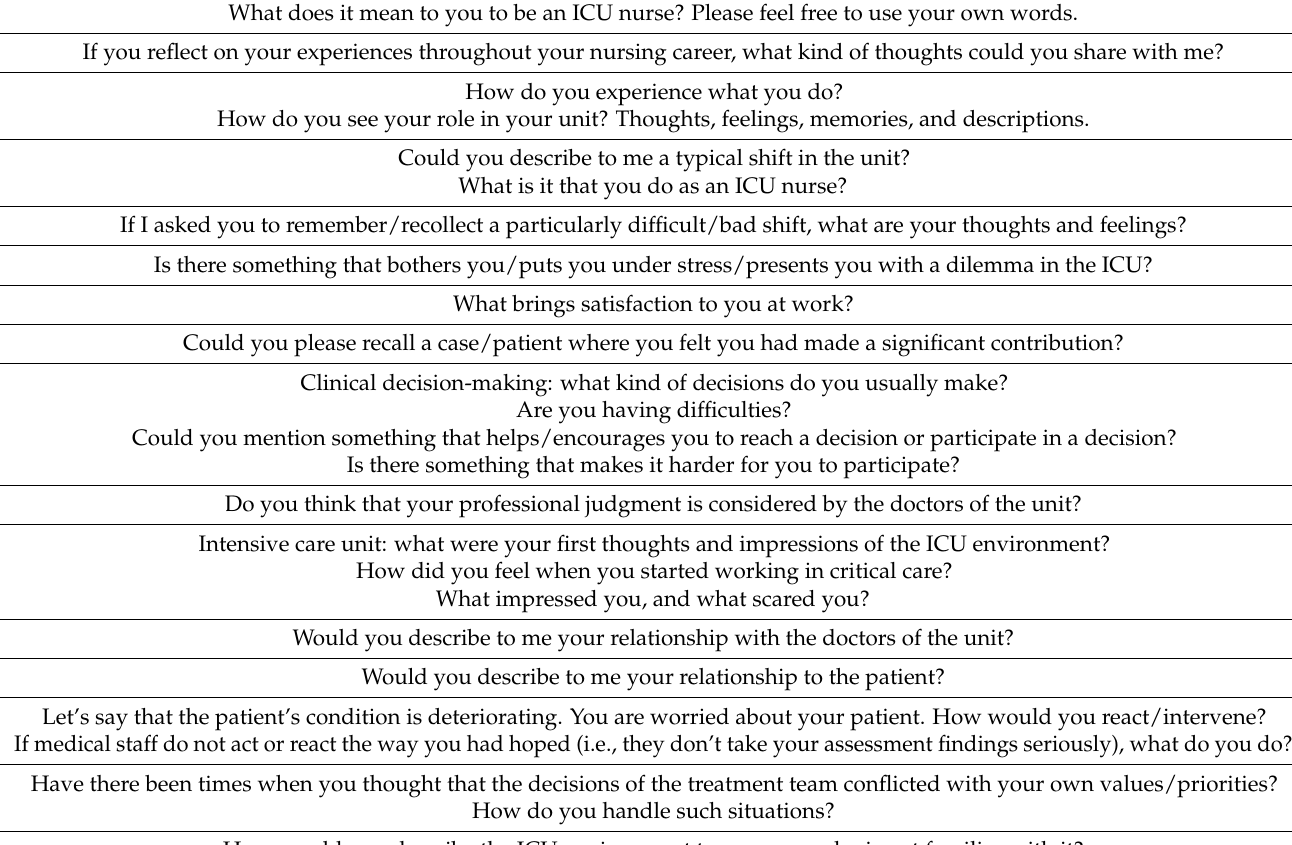
Table 2. Overview of the questions in the interview